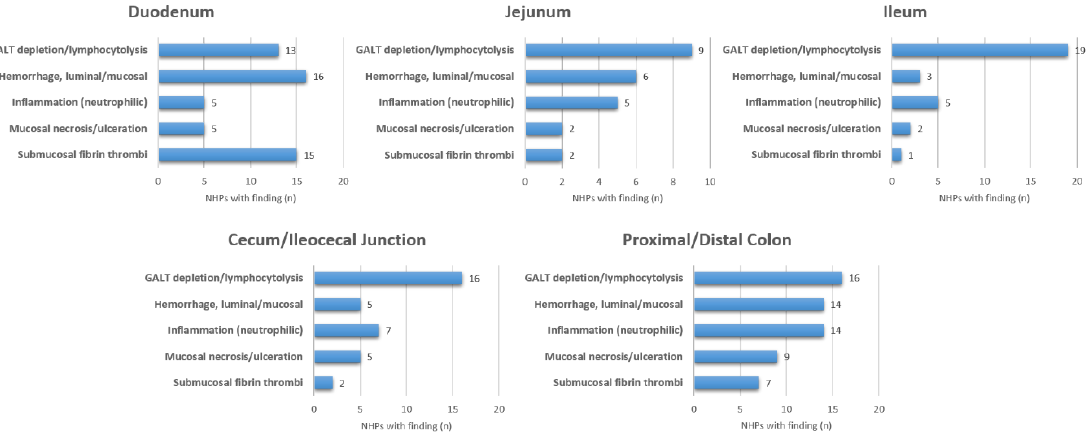
Figure 2. Summary of histopathologic findings for the duodenum, jejunum, ileum, cecum/ileocecal junction, and colon in Ebola challenged rhesus macaques ( n = 31).